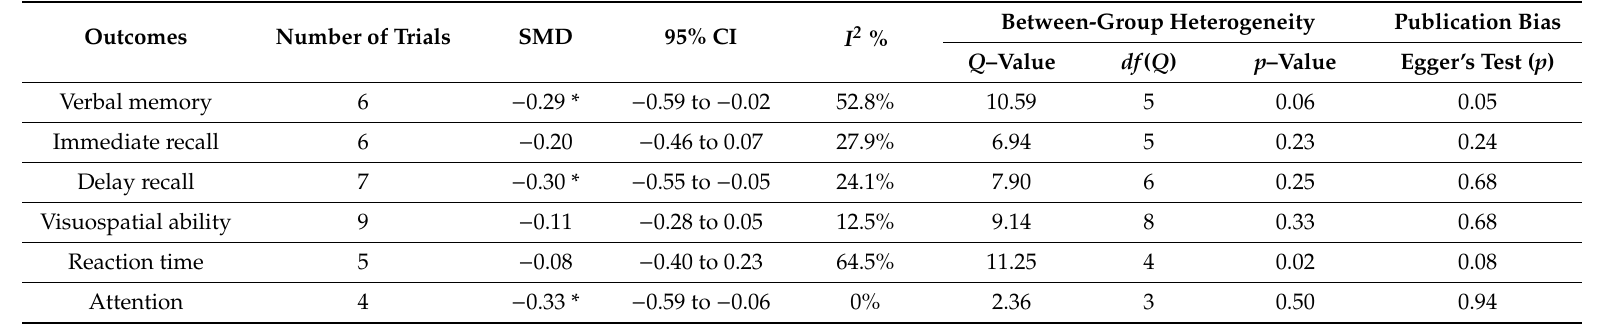
Table 2. Synthesized results for the e ff ects of concussed group vs. control